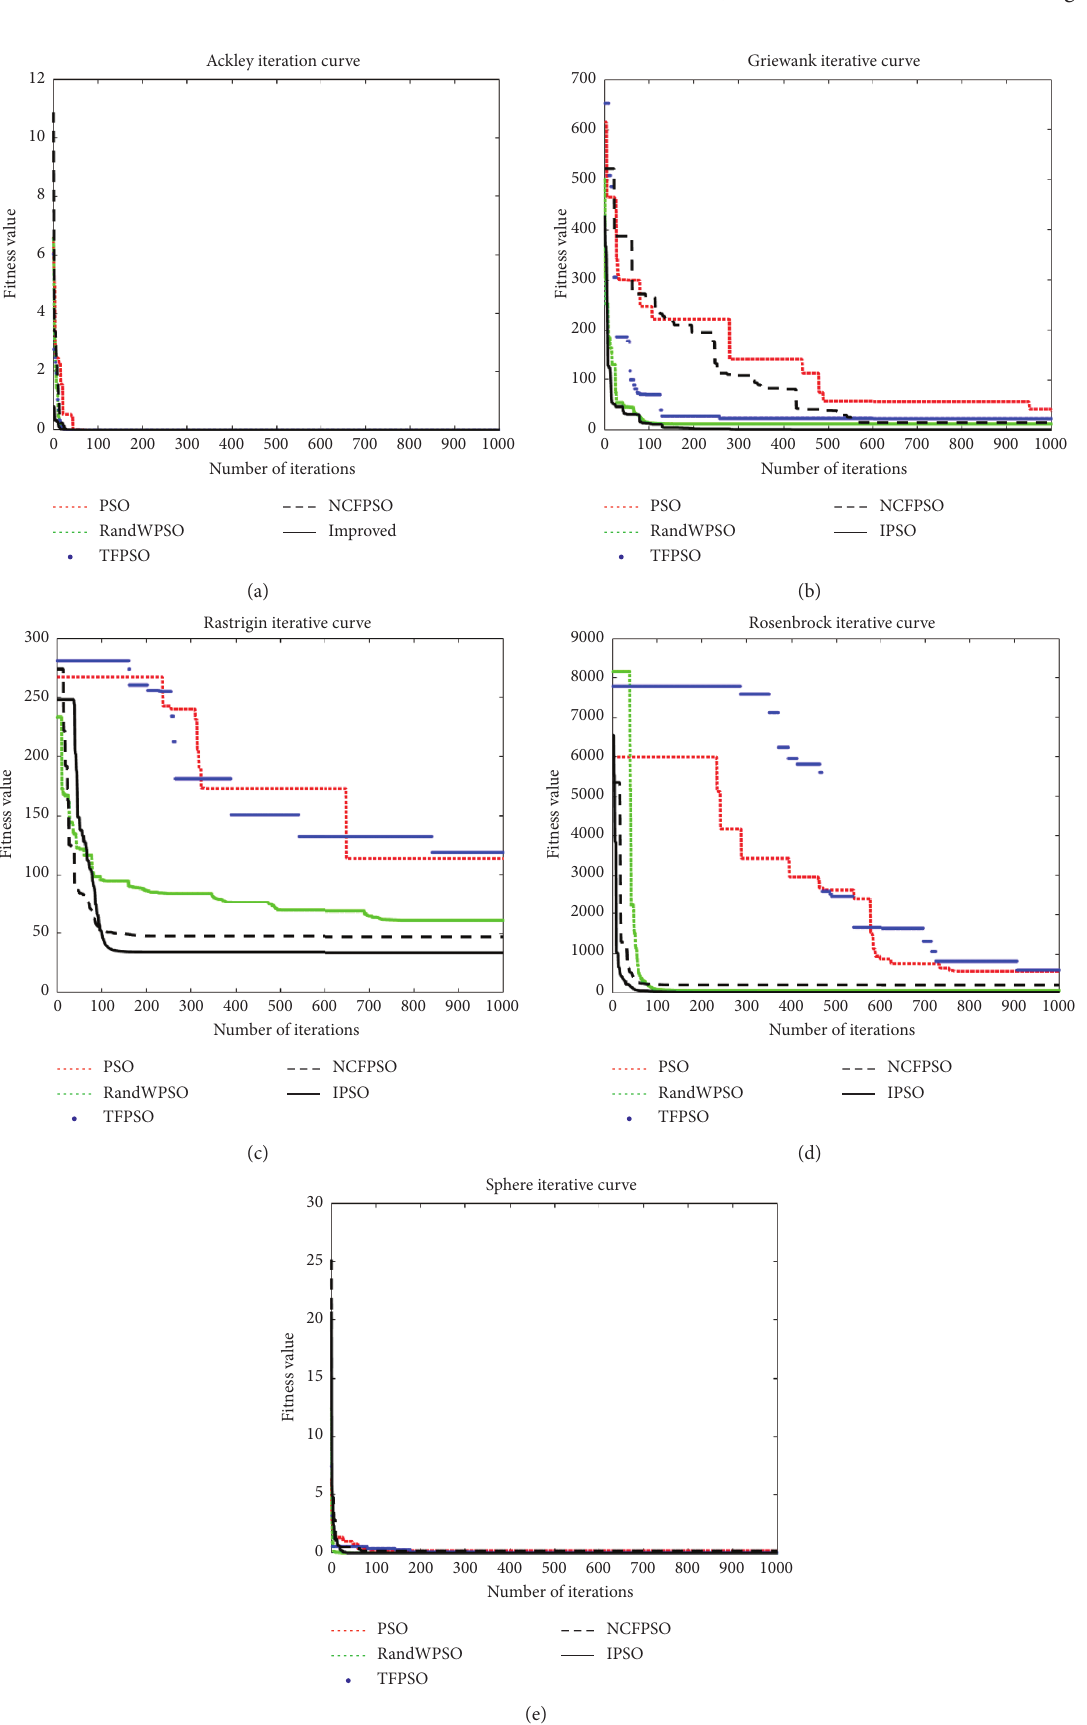
Figure 2: (a) Ackley iteration curve. (b) Griewank iteration curve. (c) Rastrigin iteration curve. (d) Rosenbrock iteration curve. (e) Sphere iteration